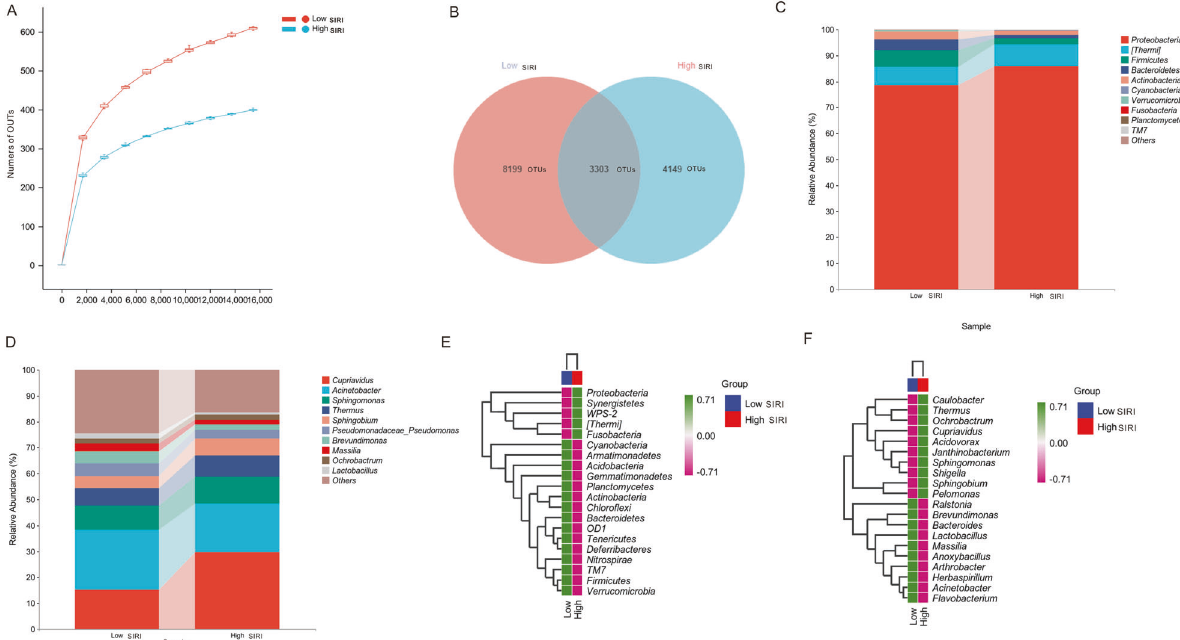
Fig. 3 Rarefaction curve and gut microbiota composition between low and high SIRI groups. A Rarefaction curve. B The Venn plots reveal the unique and common taxa between low and high SIRI groups. Compositions of gut microbial taxonomic at the phylum ( C ) and genus ( D ) levels. Up-regulated and downregulated microbial taxonomic between low and high SIRI groups at the phylum ( E ) and genus ( F ) Shannon ( P = 3e-24), Simpson ( P = 1.2e-27) and observed spices ( P = 2e-11) were remarkably different between the low and high SIRI groups, indicating that species richness was signi fi cantly richer in low SIRI group than that in high SIRI group. Based on principal- coordinate analysis (PCoA), we found that PCo1 is 12.3% and PCo2 is 8.8% (Fig. 4B). LEfSe analysis revealed that there was a remarkable difference in species diversity between the two groups (Fig. 4C).